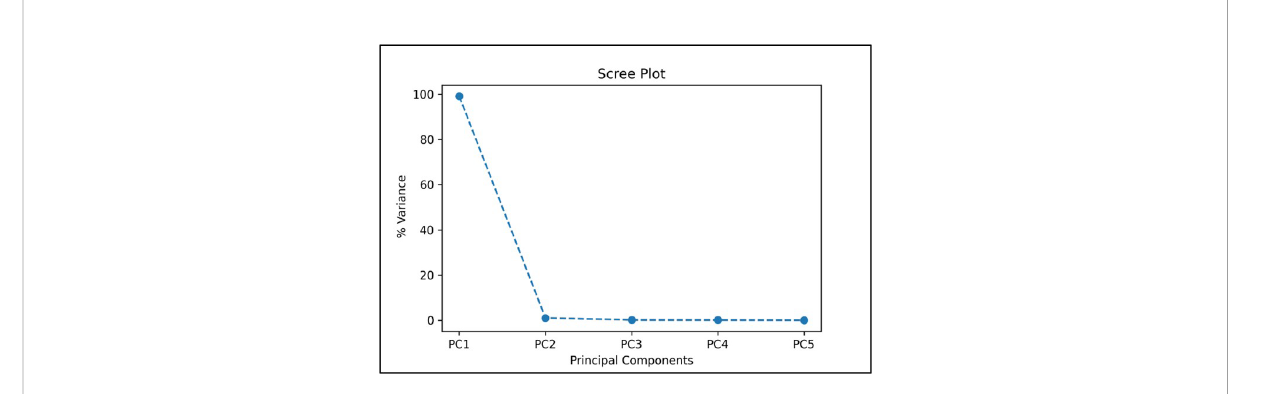
FIGURE 9 Scree plot showing the top 5 principal components when used with HSI images containing single fruit